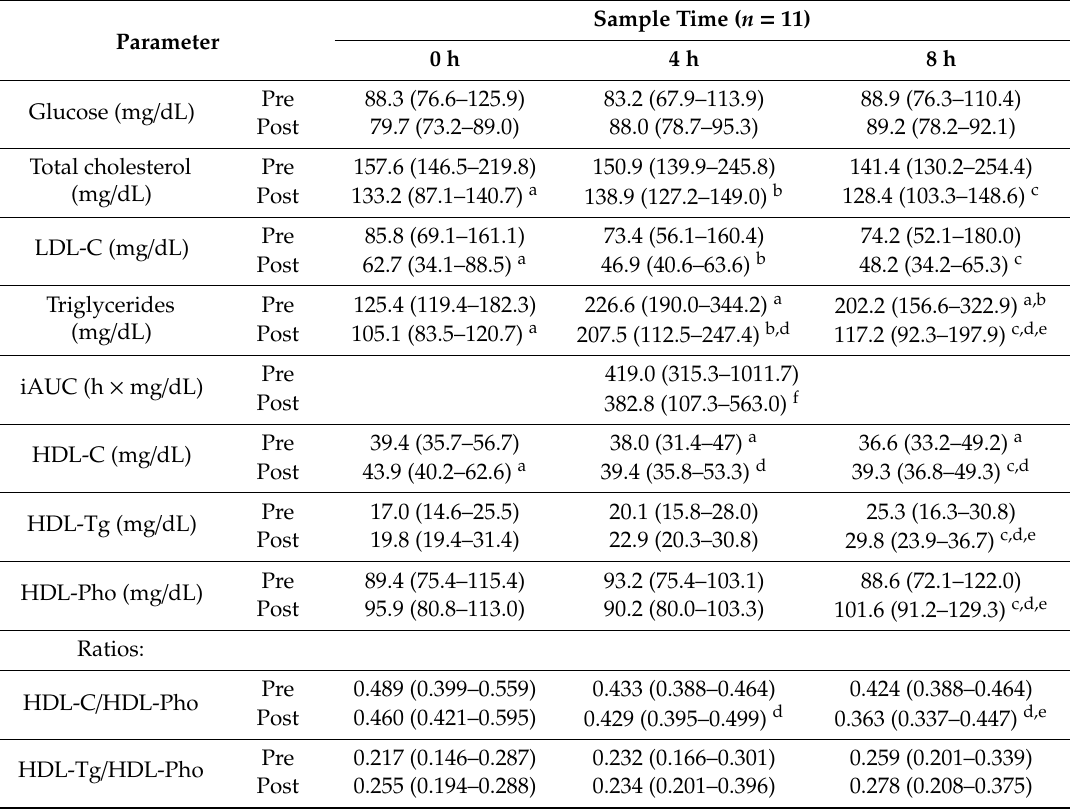
Table 2. E ff ects of MiPo supplementation on plasma lipids and glucose